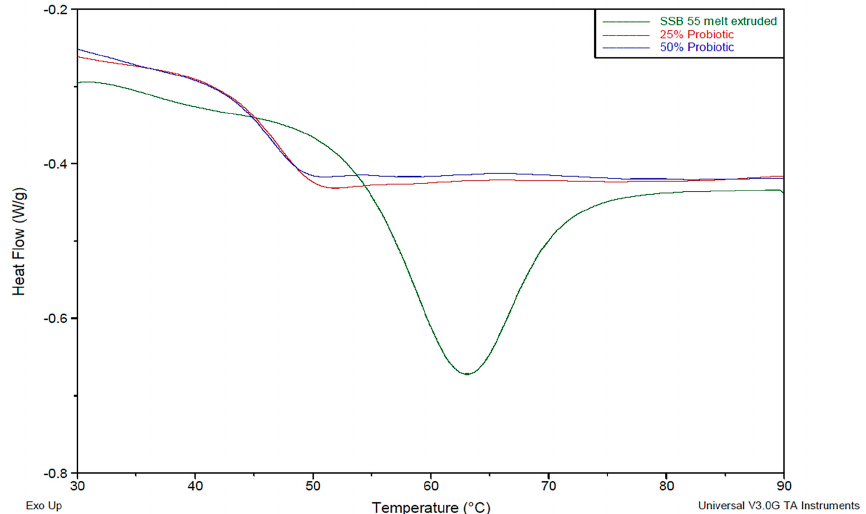
Figure 3. Overlaid thermograms of virgin SSB ® 55 pharmaceutical-grade shellac and compounded Biocare ® Bifidobacterium Probiotic at concentrations of 25% and 50% ( w / w ) in the shellac